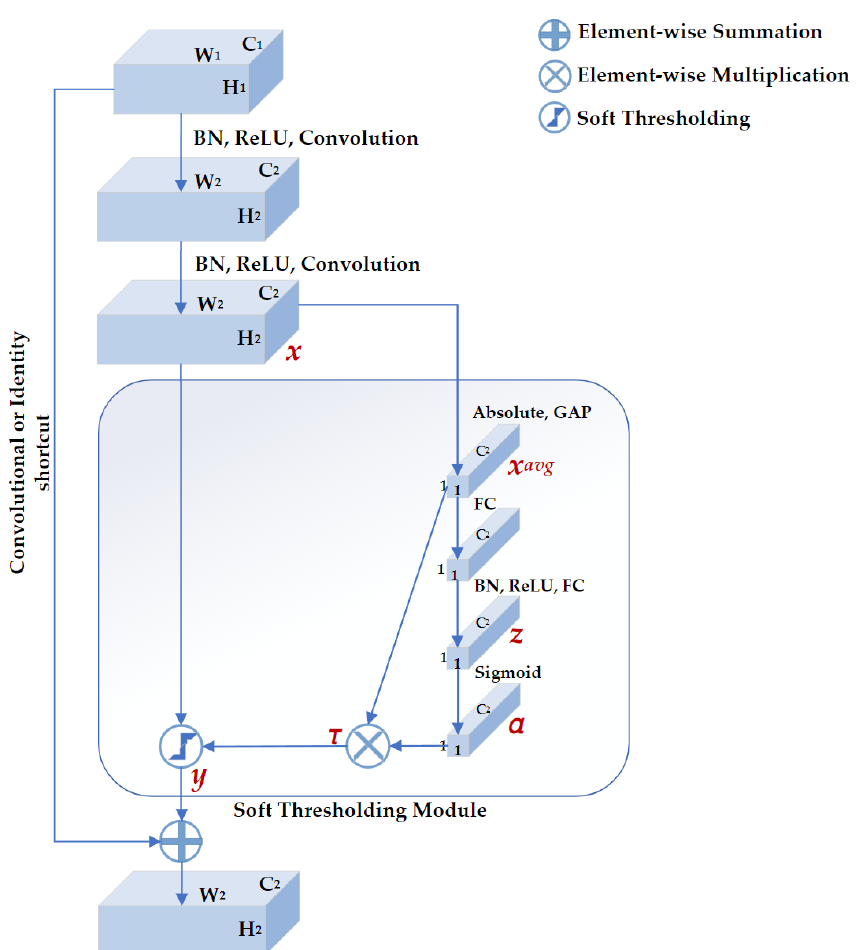
Figure 4. The structure of residual shrinkage building unit with channel-wise thresholds (RSBU-CW). H 1 , W 1 , and C 1 represent the height, width, and channels of the input feature map, respectively. H 2 , W 2 , and C 2 represent the height, width, and channels of the output feature map, respectively. There is a soft thresholding module in RSBU-CW. x avg , z , and α are the indicators of the feature maps used to determine the threshold τ . x and y are the input and output feature maps of the soft thresholding module, respectively.